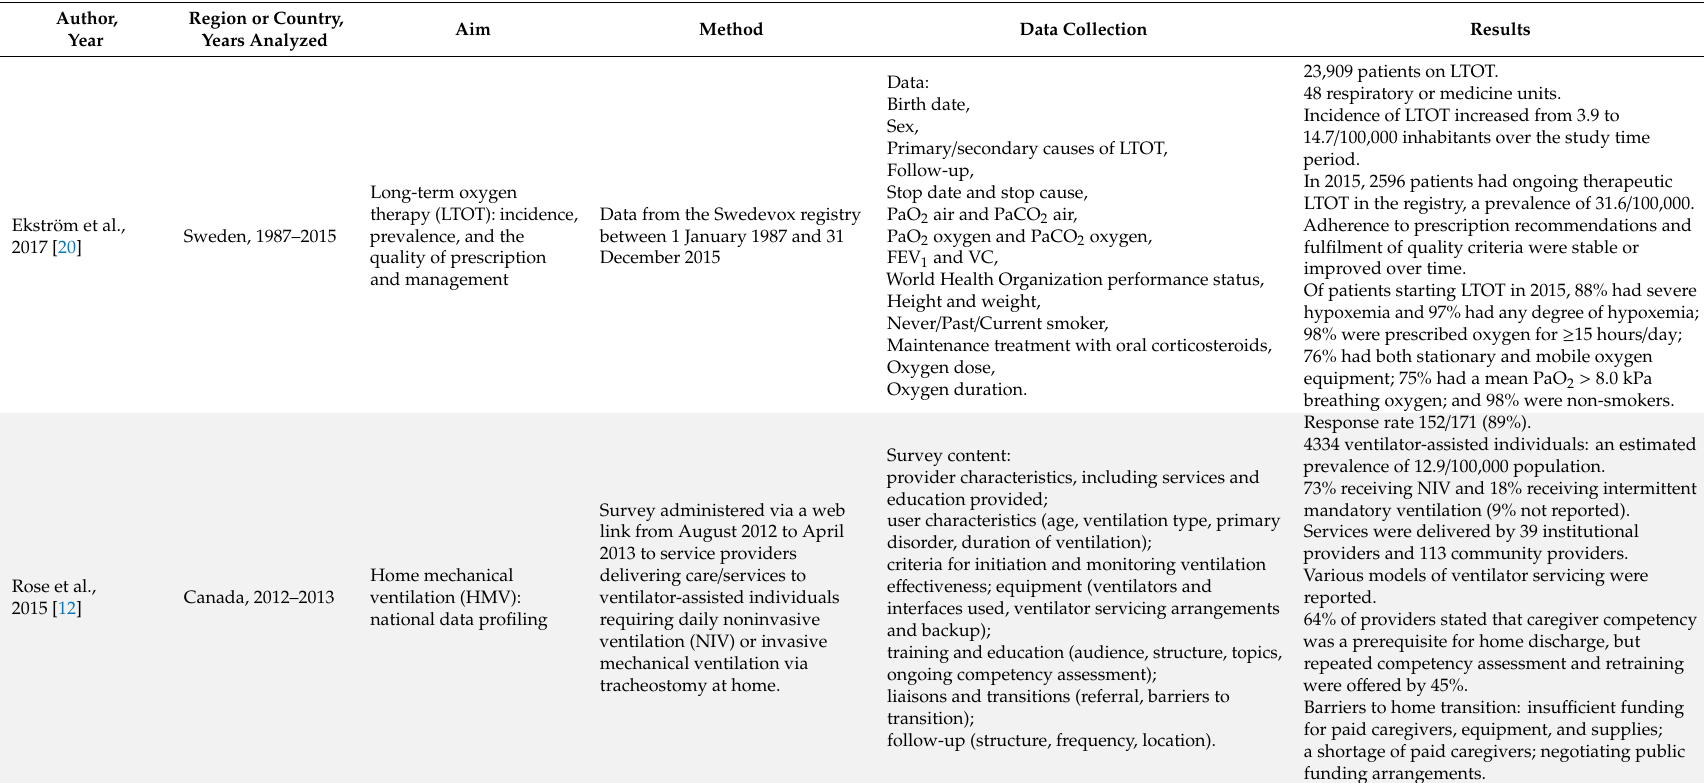
Table 1. Studies assessing the prescription of home respiratory